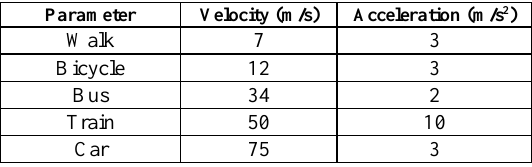
Table 2. Thresholds controlling the noise removal